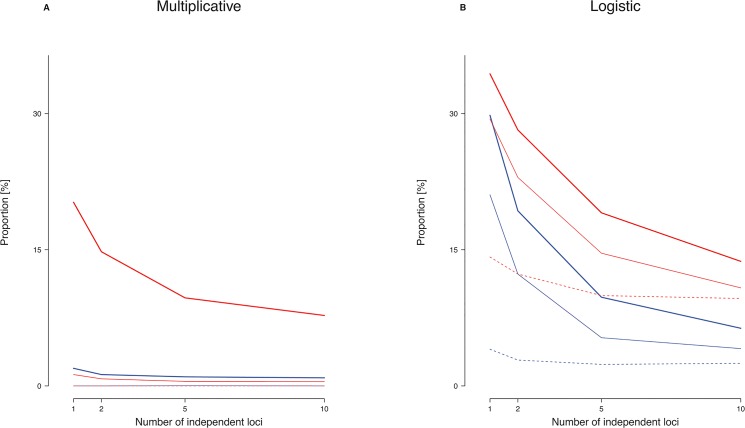
Observed proportion of epidemiologically protective causative mutations vs. number of unlinked loci underlying disease etiology.Bold solid line: pandemic disease (prevalence 10%-20%); Thin solid line: common disease (1%-5%); Dashed line: rare disease (0.1%-1.0%). (A) Multiplicative model with parameter value γ = 0.3 (blue) or γ = 0.1 (red). (B) Logistic model with parameter values α = -5; β = 1 (blue) or α = -5; β = 0.5 (red).